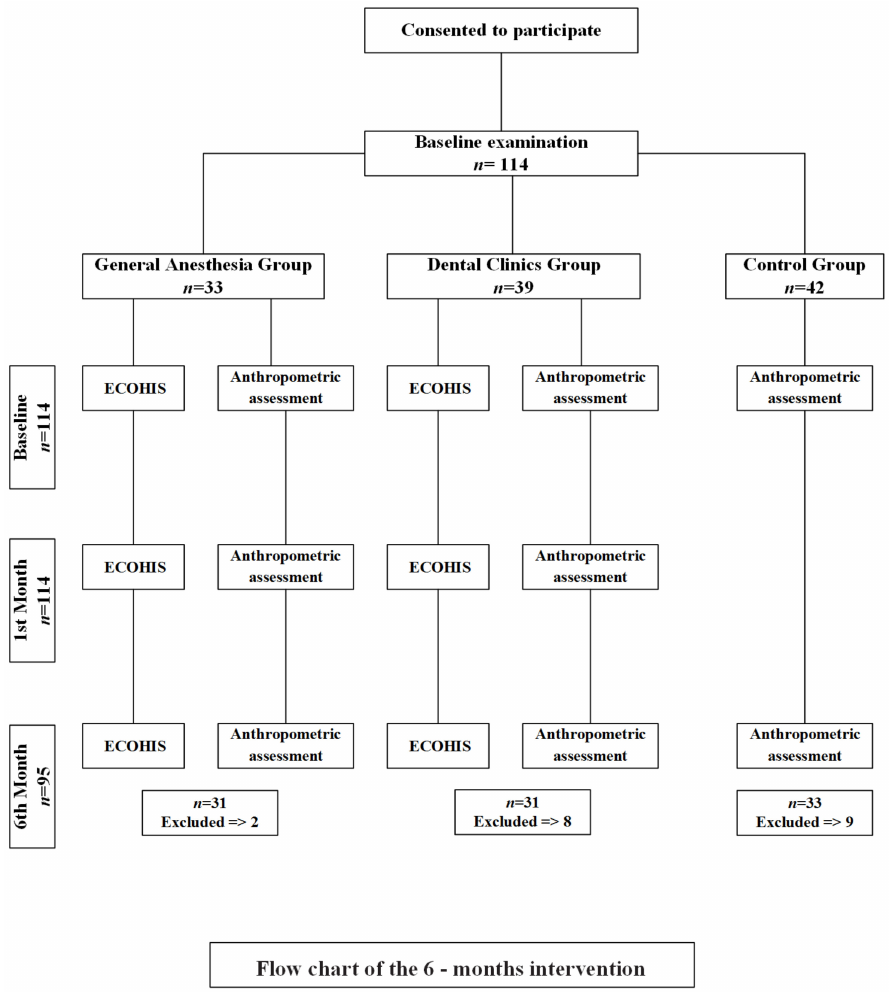
Figure 1. Flowchart of the study. Parents were verbally informed about the study and asked to sign the informed consent forms. Children’s anthropometric measurements such as oral examinations and height, weight, and BMI measurements were performed. Weights were measured with a digital scale by observing the patients wearing light clothes without shoes. Moreover, children’s heights were measured by noticing that their heels, hips, shoulders, and heads formed a straight line against the wall and their heads should be positioned in the eye–ear plane (EEP). Children’s heights were marked on a vertical plane using a standard solid metric scale ruler. BMI values were calculated with the weight (kg)/[height (m)] 2 formula [21]. The groups’ percentile categories were determined based on the reference values used in the anthropometric assessments for Turkish children promulgated in 2015